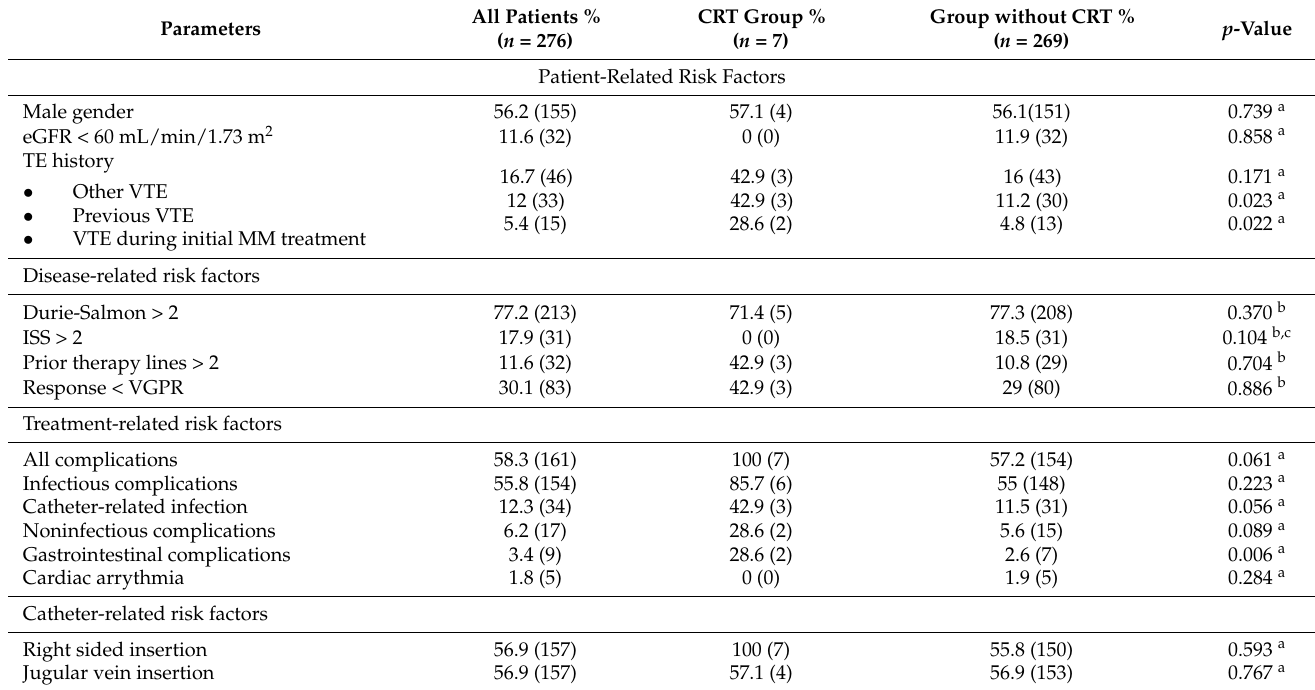
Table 2. Comparison of analyzed risk factors in patients with/or without